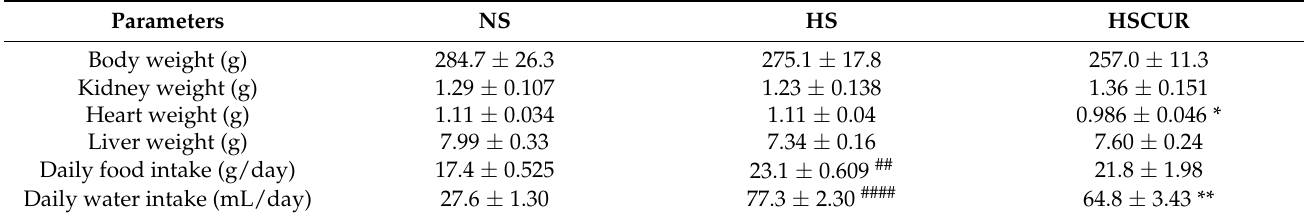
Table 1. Characteristics of SS rats after 5 weeks of treatment.